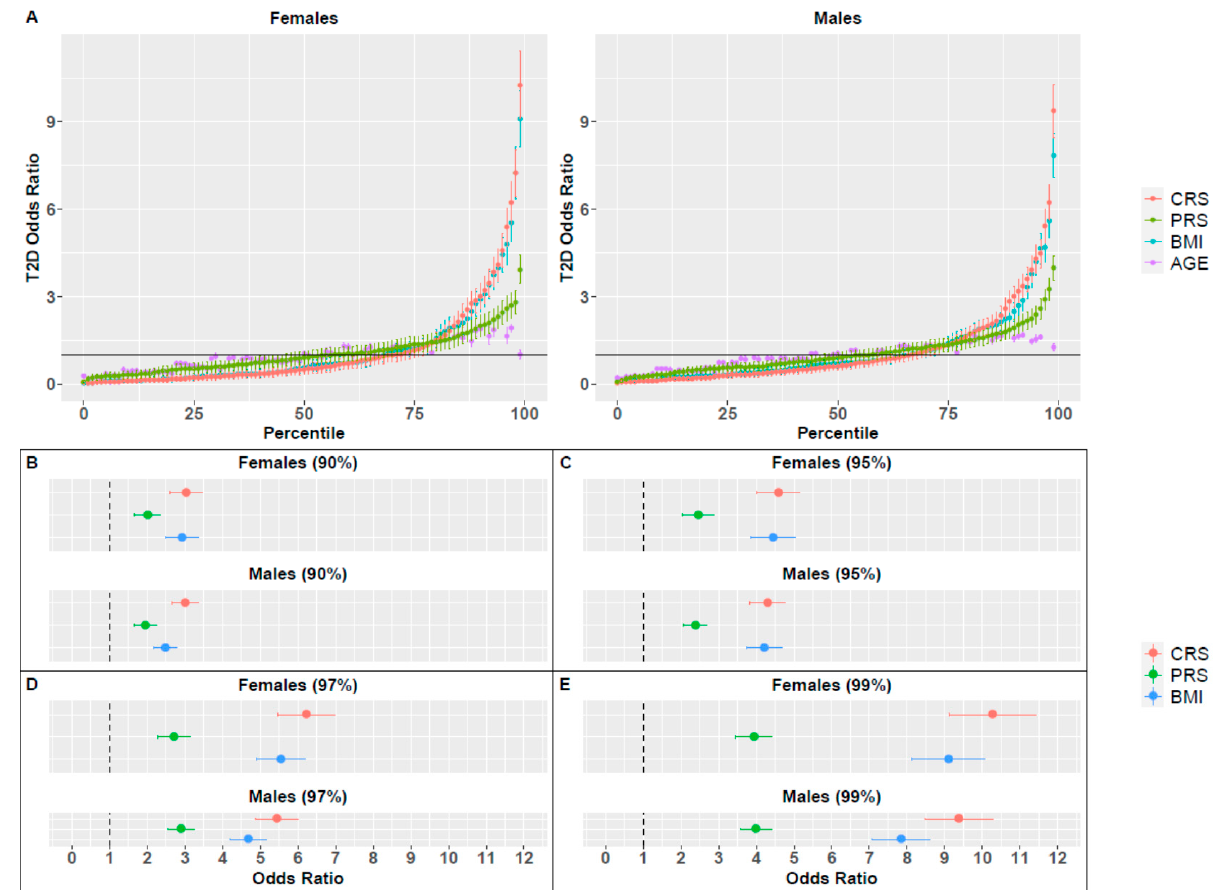
Figure 2. Odds ratio (OR) for T2D, based on BMI, PRS, CRS or age percentiles. ( A ) OR for all percentiles and all measures for females and males. Vertical lines correspond to the standard deviation of the average OR across 1000 random splits of the dataset. The horizontal line represents a neutral OR of 1. OR values for females and males in specific percentiles are also presented: ( B ) 90th, ( C ) 95th, ( D ) 97th and ( E ) 99th. Table 1. Average OR values for T2D for the different measures (BMI, PRS , CRS ) by percentiles.